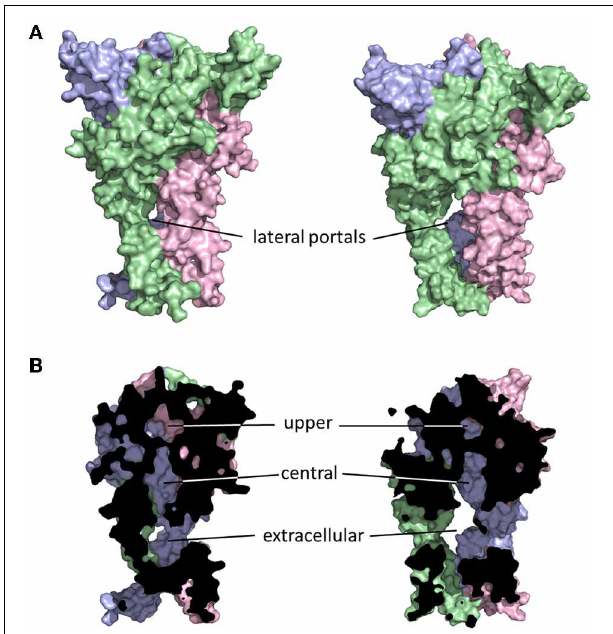
FIGURE 2 | Ion access to the transmembrane pore of a P2XR. Shown are closed (left) and open (right) P2X2R homology models built based on the resolved structures for zebrafish P2X4R (Kawate et al., 2009; Hattori and Gouaux, 2012). Subunits are presented in different colors. The lateral portals are labeled in the complete structure panels presented in (A) . The three internal cavities within the extracellular domain of the P2XR are shown in the cutaway models of (B)